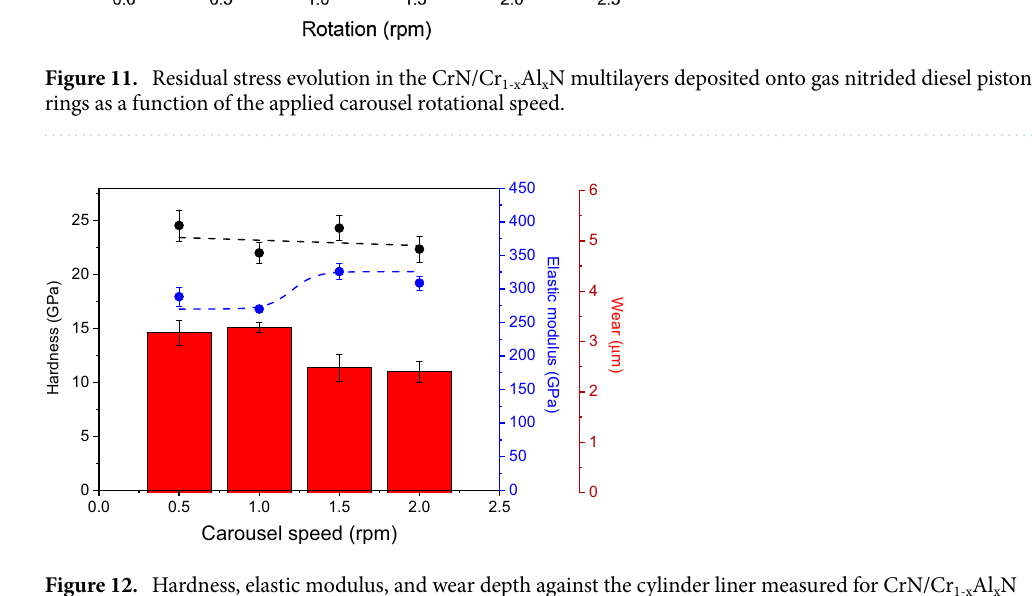
Figure 12. Hardness, elastic modulus, and wear depth against the cylinder liner measured for CrN/Cr 1-x Al x N multilayers grown on diesel piston rings at a constant bias (− 150 V) with different periodicities produced by variable carousel rotational speed (0.5 rpm, 1.0 rpm, 1.5 rpm, and 2.0